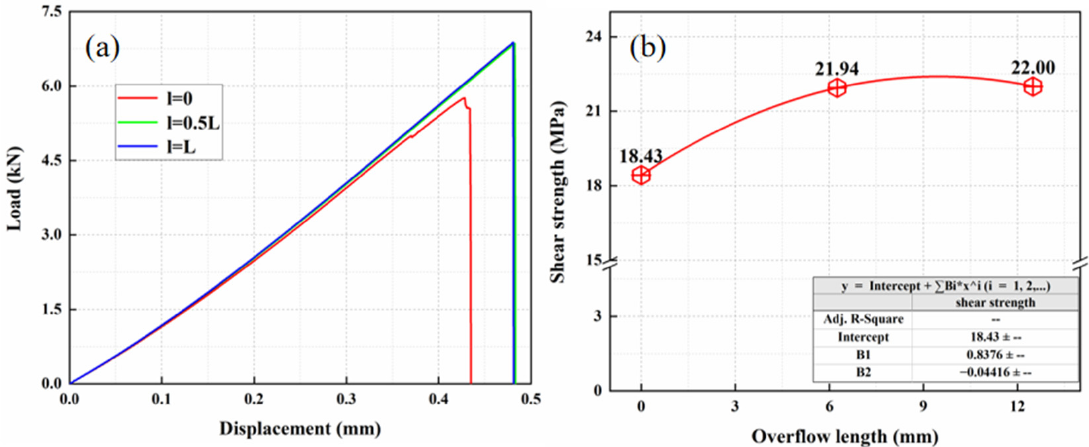
Figure 13. The result of adhesive layer overflow length: ( a ) load displacement curves and ( b ) shear strength.